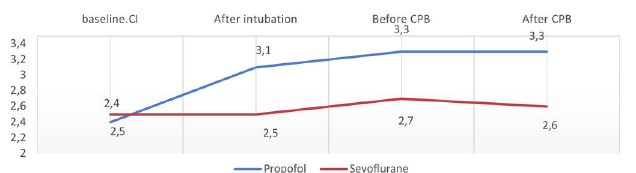
Figure 3 - Cardiac index before anaesthesia and during surgery.